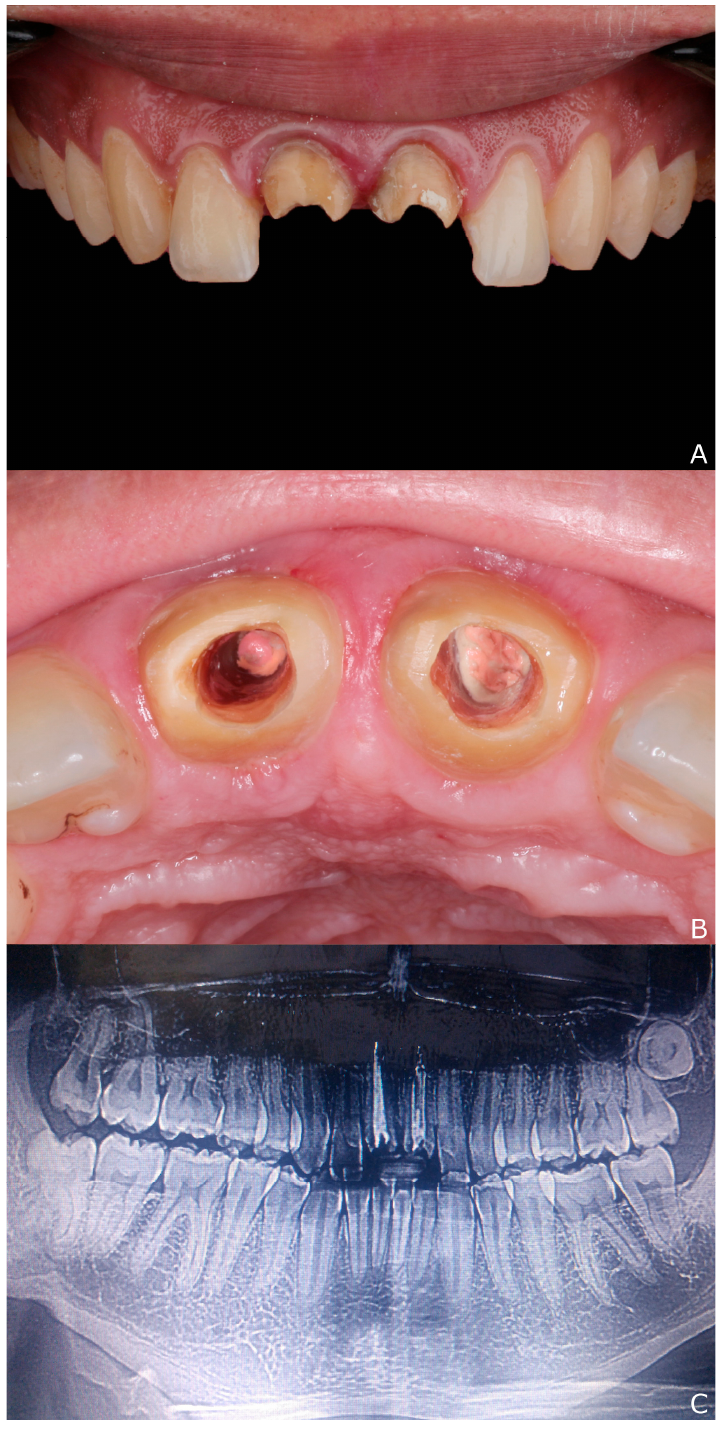
Figure 2. After removal of the restoration: ( A ) the remaining maxillary central incisors; ( B ) wide canals surrounded by thin ‐ walled roots; and ( C ) radiographic examination reveals the thin remaining walls.